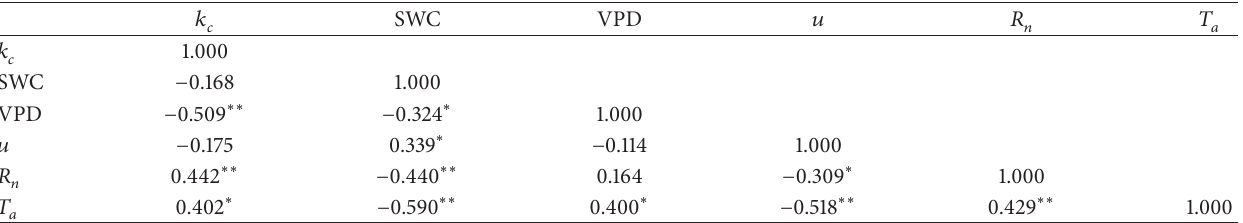
Table 1: Pearson product-moment correlation coefficients for the relationships between daily 𝑘 𝑐 and daily average values for environmental variables: SWC at a depth of 5 cm, atmospheric VPD, wind speed ( 𝑢 ), 𝑅 𝑛 , and 𝑇 𝑎 over the swamp meadow on a daily basis for days without rain during the 2004 growing season ( 𝑛 = 106 ).